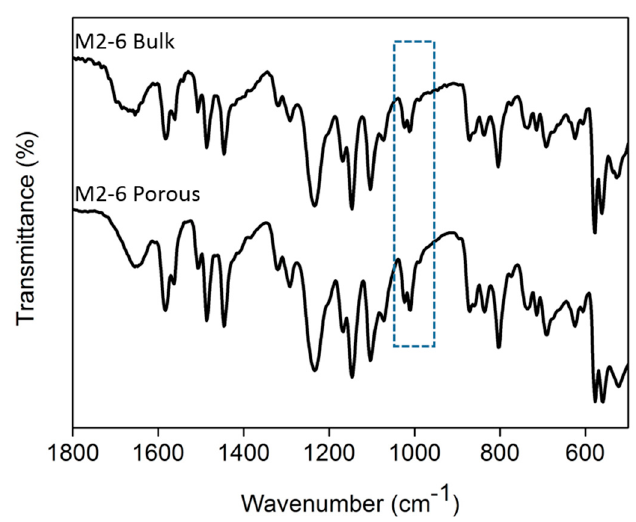
Figure 11. ATR-FTIR spectra of the bulk and porous membrane M2-6.